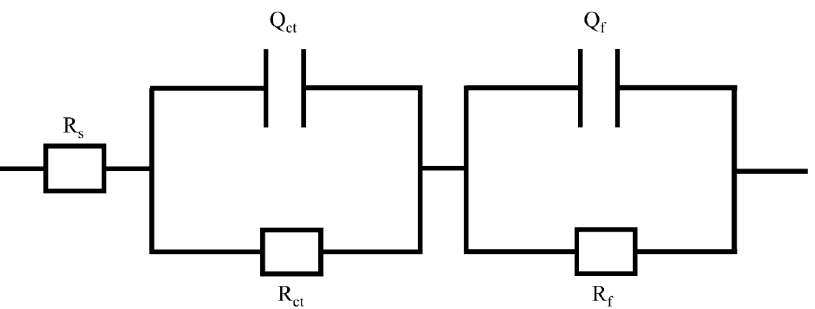
Figure 13. Phase angle diagram (Phase angle vs. f) of AZ80 and WE43 alloys in 0.6 M NaCl and Na 2 SO 4 solution.